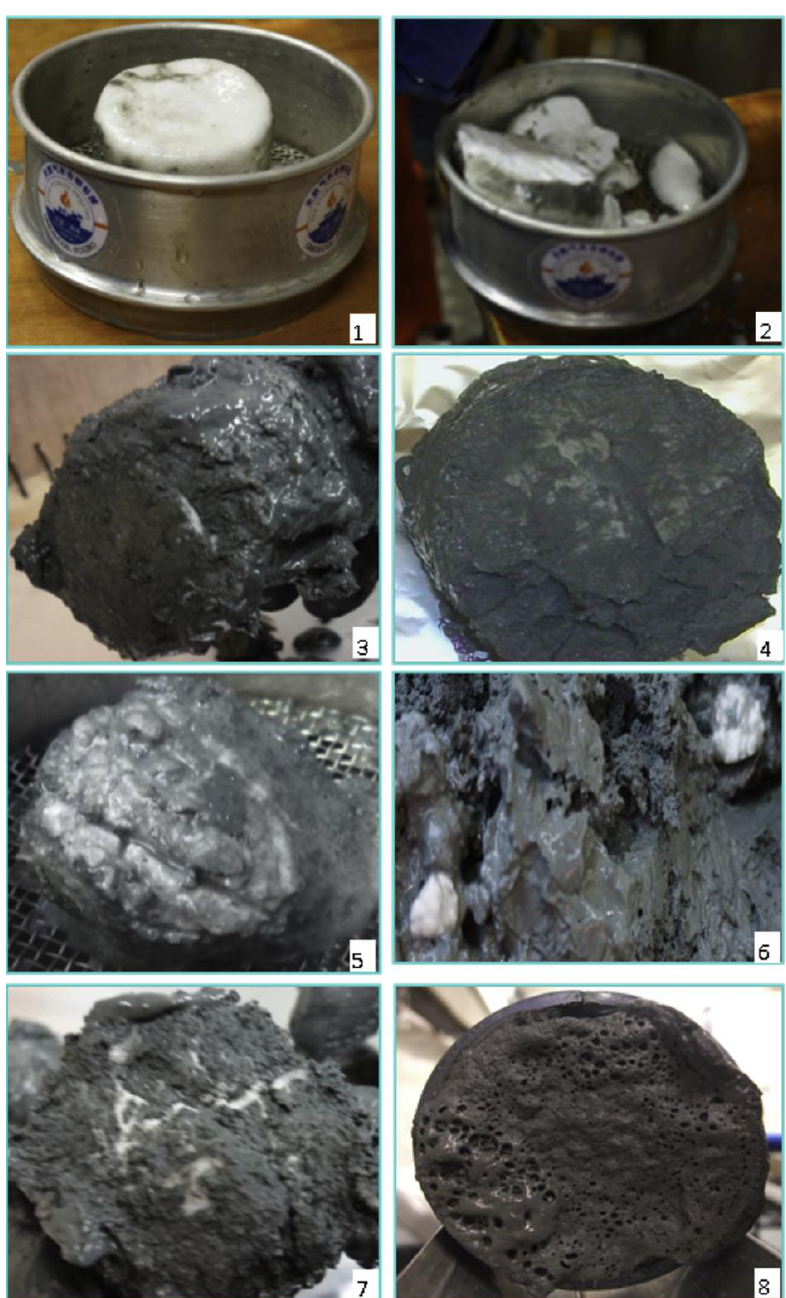
Figure 3. Gas hydrate morphologies in core samples recovered from GMGS2 drilling sites, South China Sea. 1 and 2 (Site GMGS2-08F) massive; 3 and 4 (Site GMGS2-08E) laminated; 5 (Site GMGS2-08E)